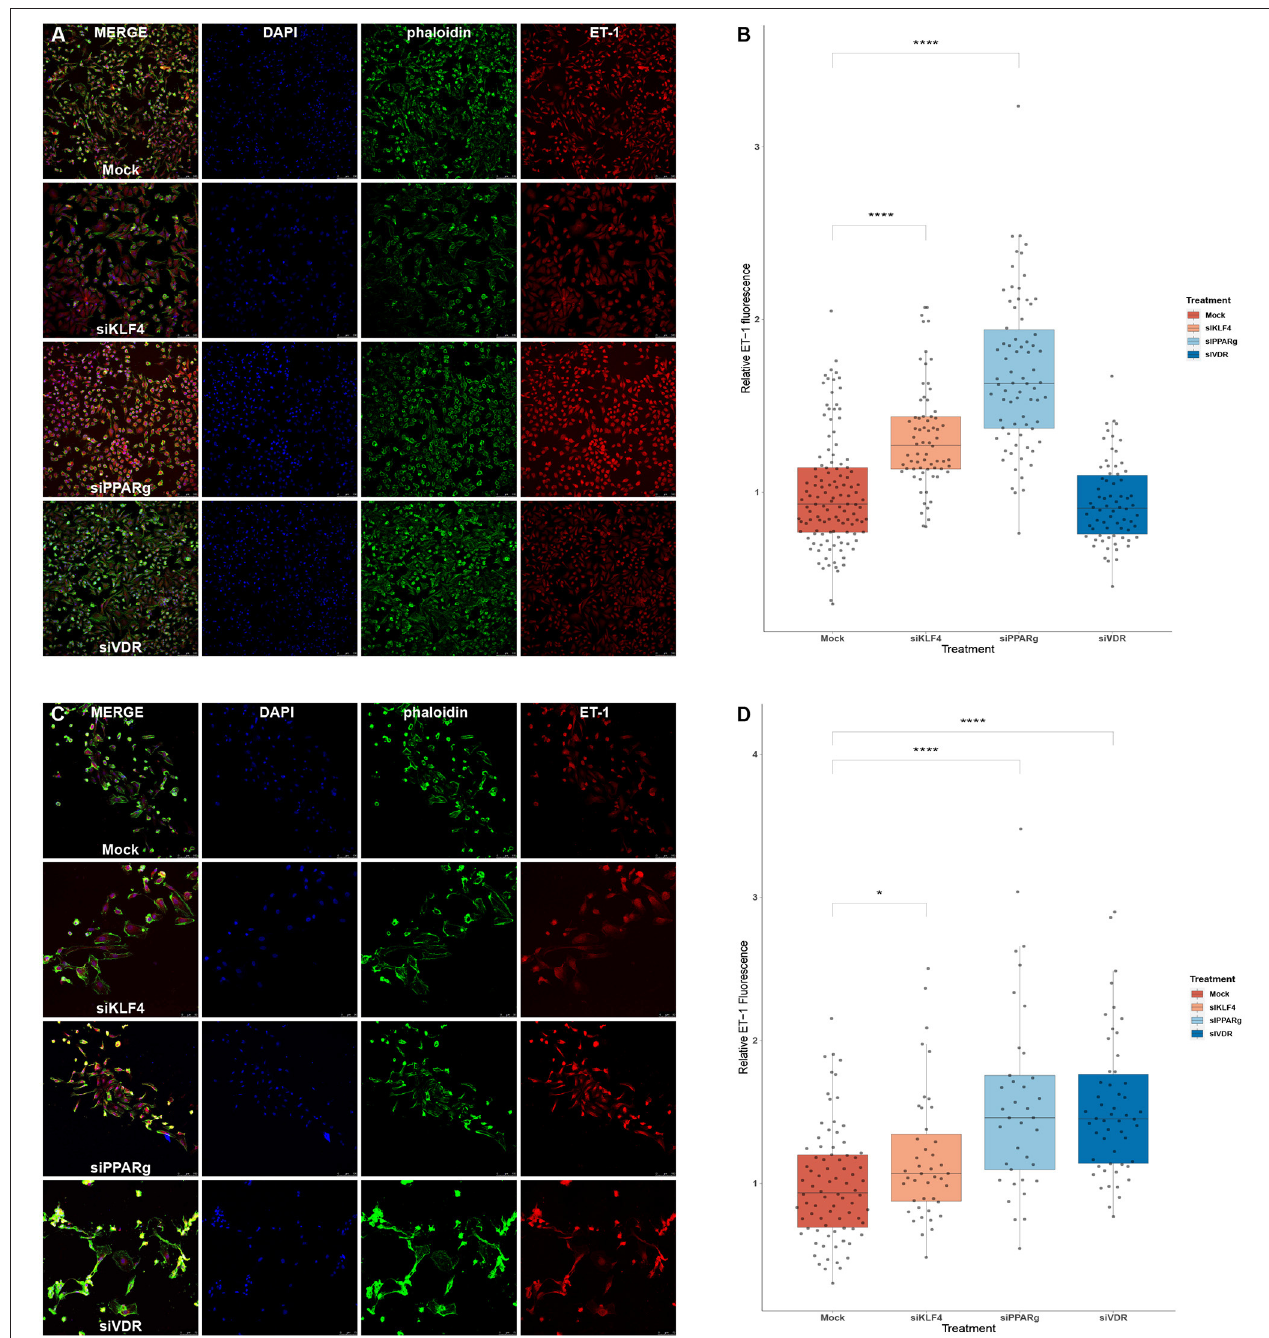
FIGURE 6 | Silencing PPAR γ increases ET-1 production in HeLa and PAECs while VDR does only in PAECs and KLF4 in HeLa. (A) Representative immunofluorescences for HeLa cells. (B) Quantification of ET-1 production using immunofluorescence in HeLa, treatment with siKLF4 and siPPAR γ increases ET-1 fluorescence ( n = 4). (C) Representative immunofluorescences for PAECs. (D) Quantification of ET-1 production using immunofluorescence in PAECs, treatment with siPPAR γ and siVDR show the highest increase in ET-1 fluorescence, while siKLF4 has a slight increase ( n = 6). Data are represented as box plots depicting the quartiles and dots representing single cells measured. A Kruskal-Wallis test with a Dunn’s correction was used for statistical analysis (* p > 0.05, **** p > 0.0001). PPAR γ , peroxisome proliferator-activated receptor γ . ECE1, generating more active endothelin (27). However, VDR be expected that the system would saturate rapidly in the case increases the amount of NO by directly activating endothelial of ET-1, as the amount of preproendothelin mRNA did not increase (27), and the overall result would be vasodilation. This NOS (eNOS), generating a vasodilator effect (27). So it would